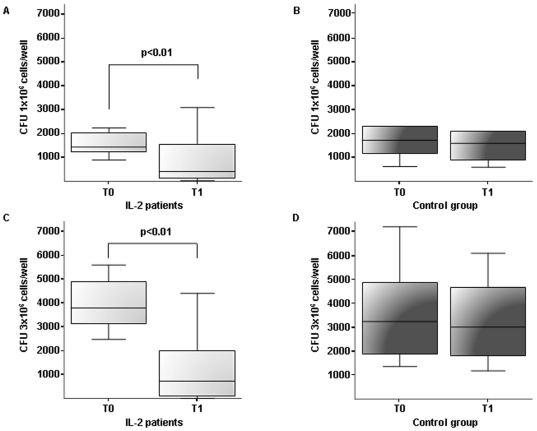
Mycobacterial growth (CFU: Colony Forming Unit) before (T0) and after (T1) IL-2 adjuvant treatment (A,C) compared to cART treatment alone in control group (B,D).CFU growth has been tested in different aliquots of PBMC cultures of 1×106 cells/well (A,B) and 3×106 cells/well (C,D). In IL-2 treated patients a significant reduction in mean residual mycobacterial growth was observed in both experimental conditions of PBMC cultures (P<0.01). Significant results are emphasized by square brackets with respective P values.